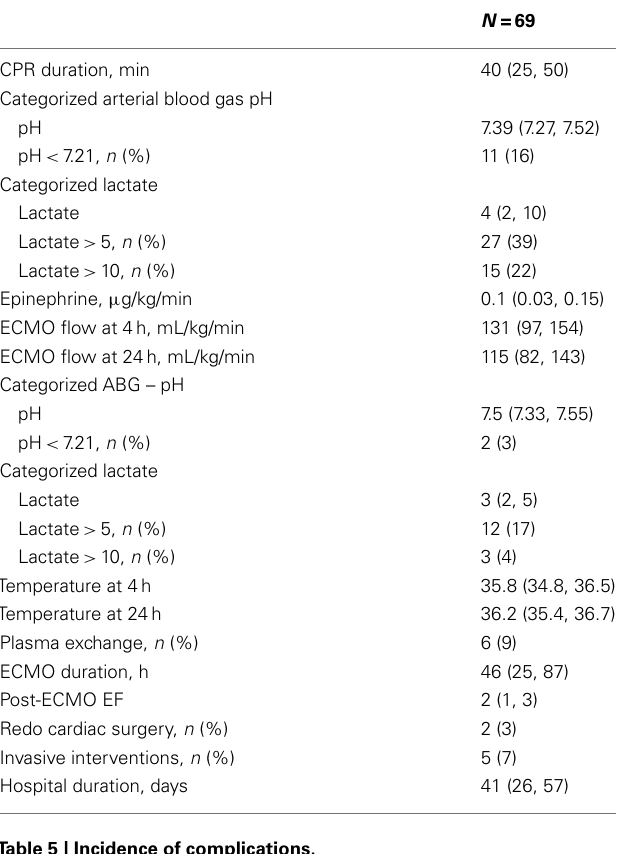
Table 4 | Pre and during – ECMO parameters.